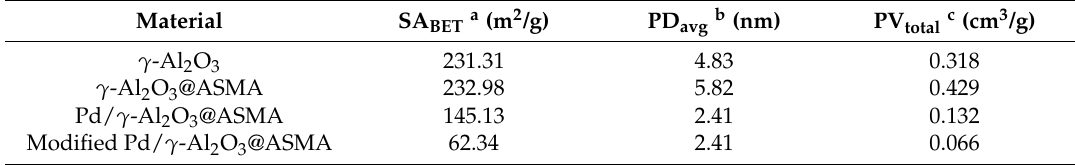
Table 1. Brunauer-Emmett-Teller (BET)-surface area, pore size, and pore volume of supports and